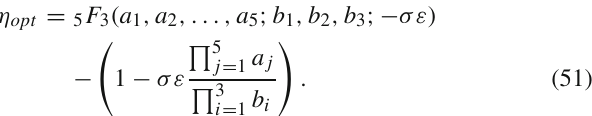
Table 1 The seven-loop ( ε -expansion) hypergeometric-Meijer ( ε 7 ;HM) resummation results for the exponents ν,η and ω of the self-avoiding walks model ( N = 0 ) . The recent predictions of what is called self-consistent (SC) resummation algorithm introduced in Ref. [54] is also listed in the table. Besides, we list results from conformal bootstrap (CB) calculations [27], Monte Carlo simulation (MC) for ν from Refs. [14,32] and η from Ref. [15]. Also the predictions of the resummation of six-loop series using Borel with conformal mapping (BCM) algorithm ( ε 6 ) from Ref. [32] and five-loop ( ε 5 ) from same reference is included